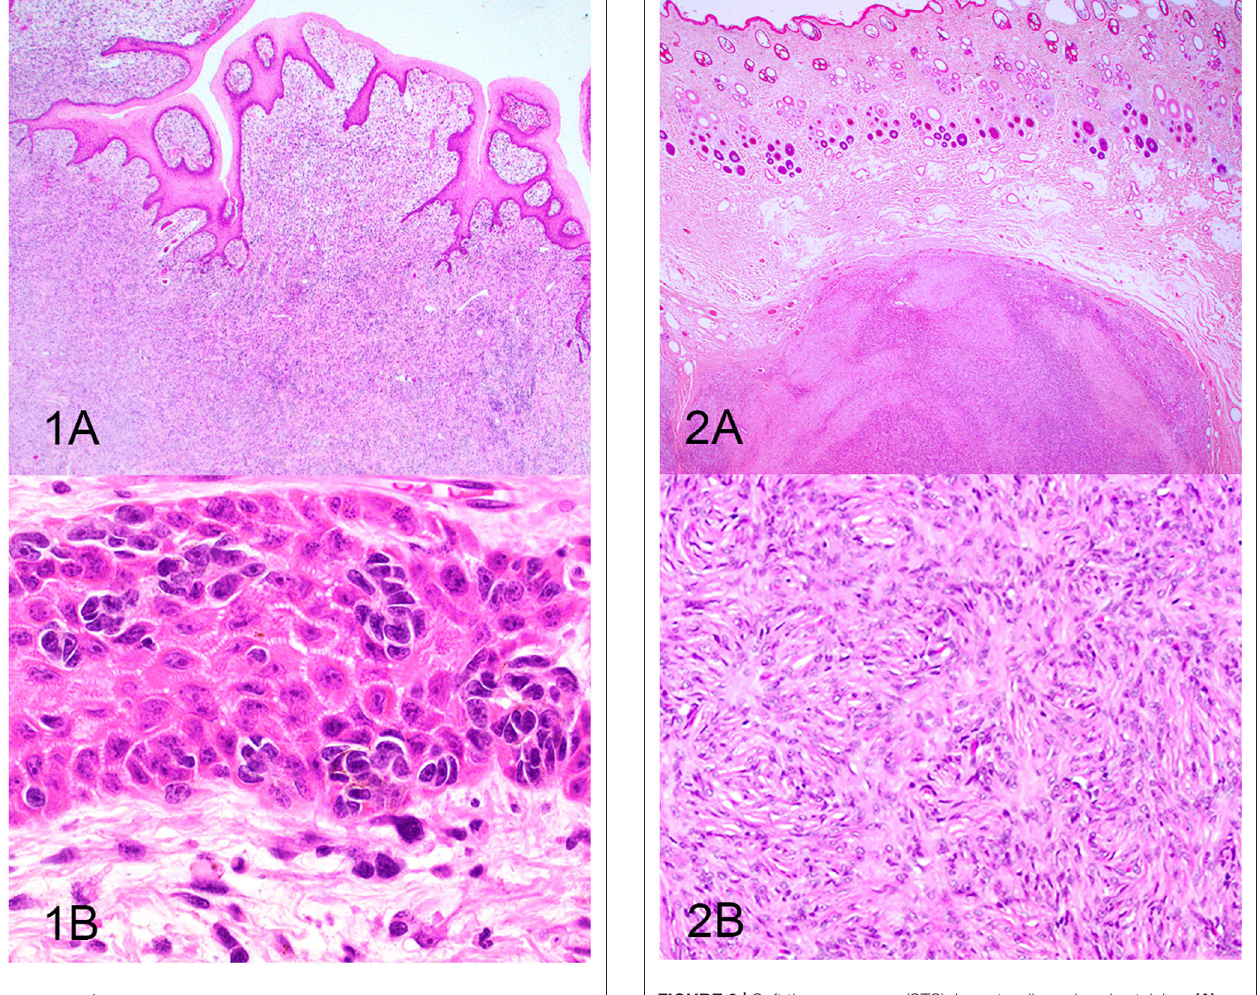
FIGURE 1 | Oral malignant melanoma (OMM), hematoxylin and eosin staining. (A) OMM with junctional activity and composed predominantly of subepithelial spindloid cells with < 5% containing pigment. Magnification, × 4. (B) Higher magnification of (A) highlighting junctional activity (intraepithelial nests within the basal layer of the epithelium). Magnification, × 40.